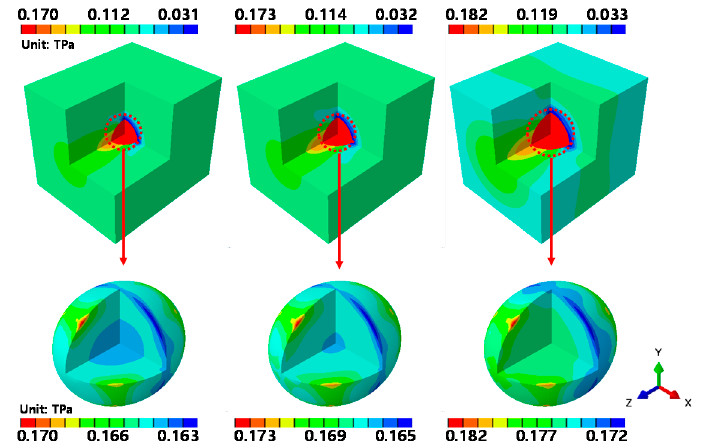
Figure 11. ε (cid:2936)(cid:2936) -direction RVE analysis results. Figure 11. ε zz -direction RVE analysis